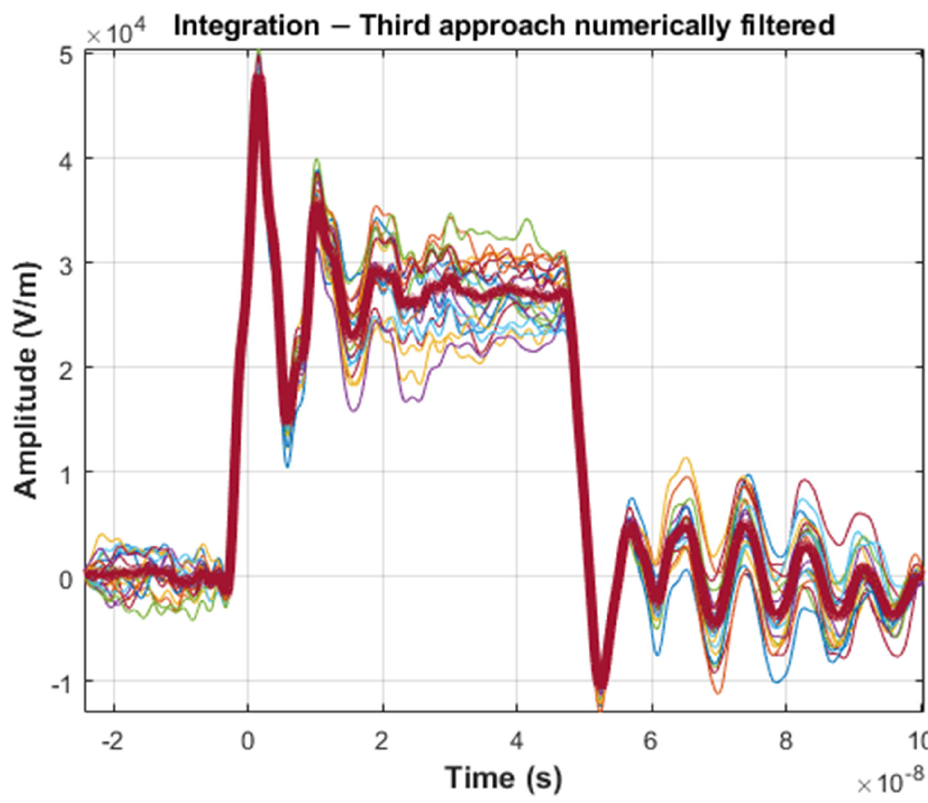
Figure 11. Digitally filtered integrated signal together with the averaged one based on the set of acquisitions.